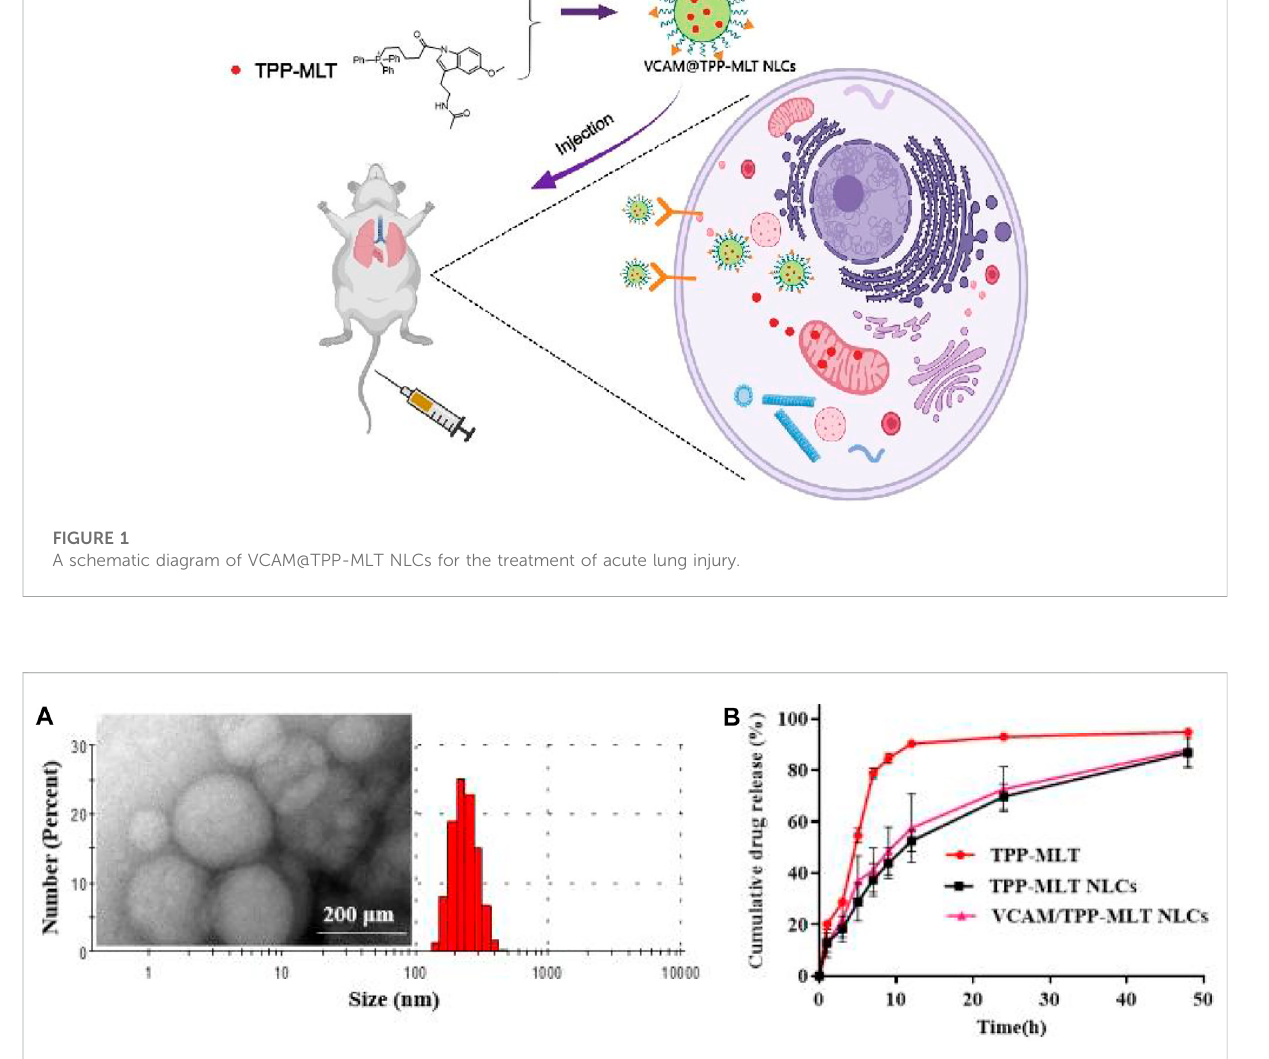
FIGURE 2 Characterization of VCAM@TPP-MLT NLCs. (A) Representative TEM image and DLS trace of VCAM@TPP-MLT NLCs. (B) Release behavior of VCAM@TPP-MLT NLCs in pH 7.4 PBS.